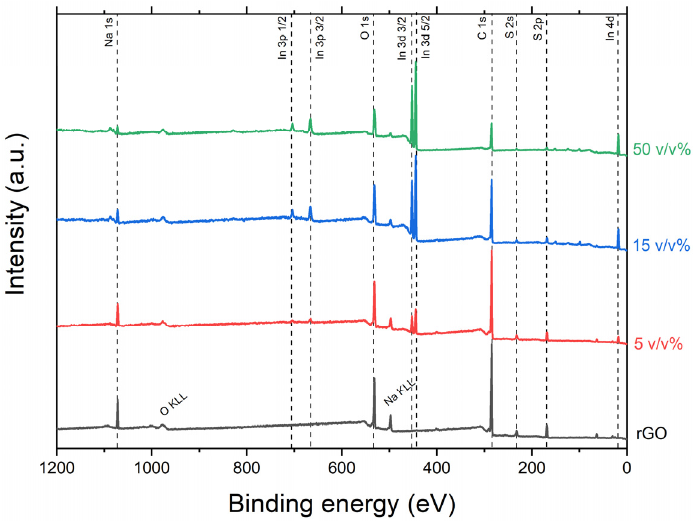
Table 1. Analysis of the chemical surface states of the elements.